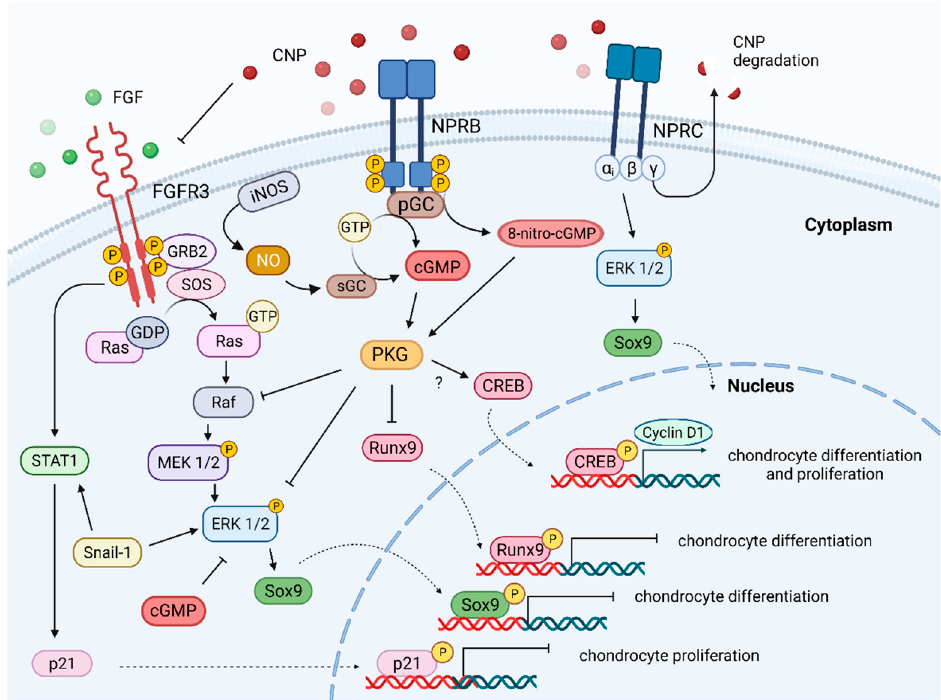
Figure 1. Signaling pathways activated or inhibited by CNP in the bone growth plate region. The cellular effects of CNP action are mediated through the NPR-B receptor, stimulating intracellular molecule cGMP production, which further results in the protein kinase G (PKG) activation. PGK activation by CNP results in the MAPK signaling pathway, which results in chondrocyte proliferation and differentiation. NPR-C receptor degrades CNP; additionally, Gi protein of the receptor modulates the level of ERK1/2 inside the cell. ? ‐ it is not confirmed if CREB is activated by PKG